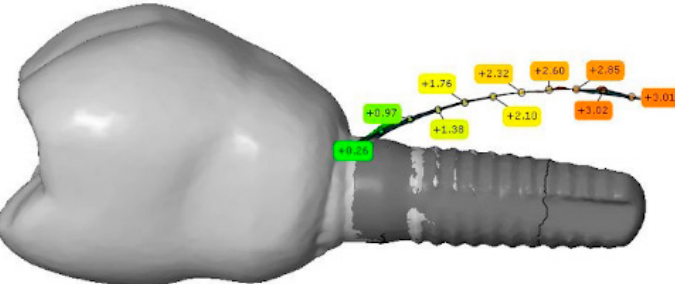
Figure 4. Matching between the a priori information and the ultrasound data. The numbers describe the thickness of bone above the implant surface. The color shades are defined as follows: orange corresponds to a thickness of 3 mm and green to a thickness of zero.